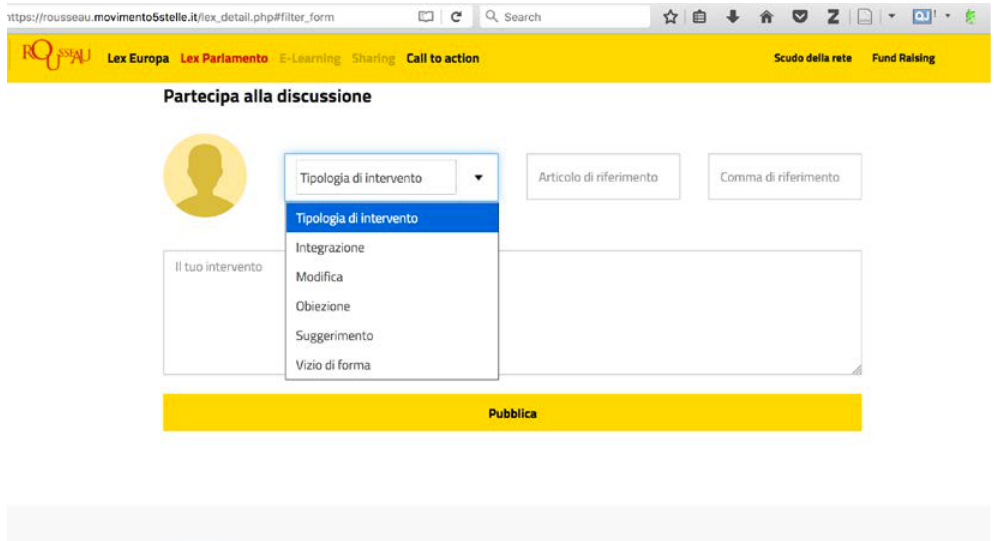
Figure 2: The categorization of comments on a bill proposal (source: